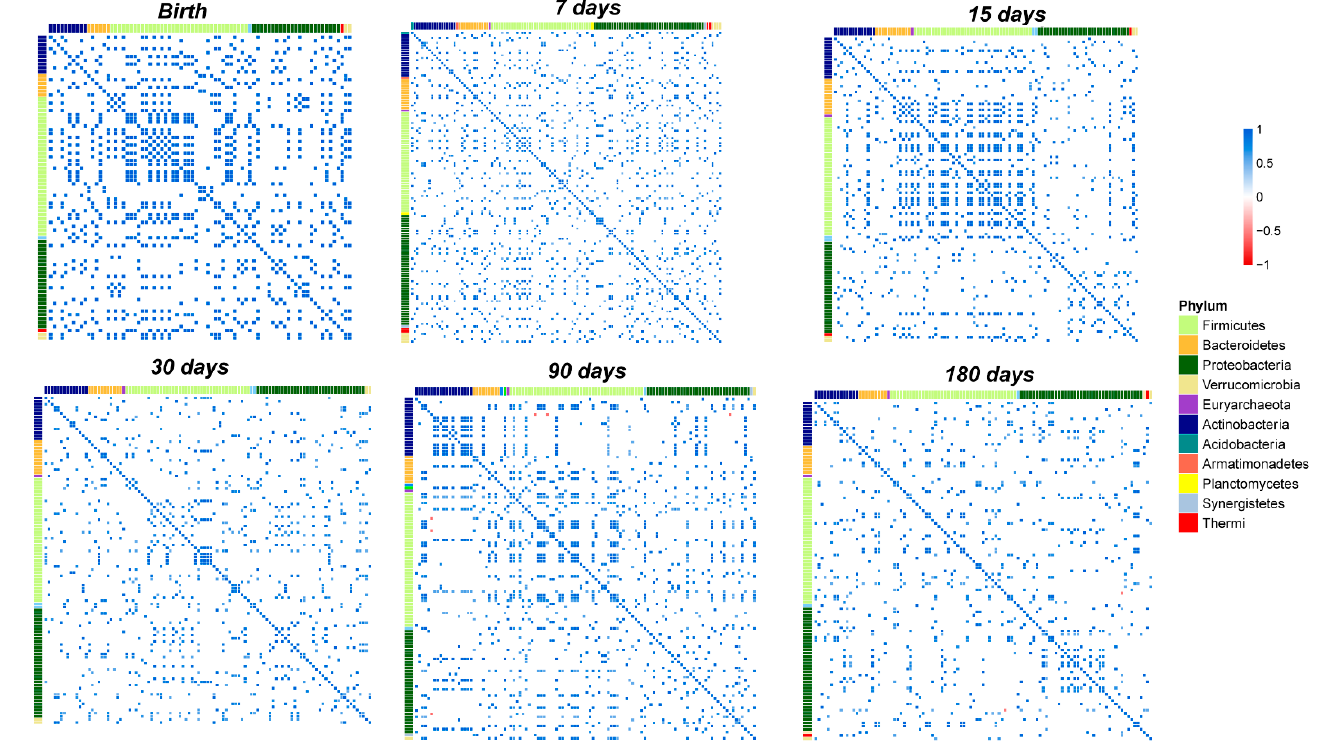
Figure 7. Pearson’s correlation heatmaps of fecal OTUs. Panels that are labelled as Birth, days 7, 15, 30, 90, and 180 show the correlation (coloured squares) heatmaps between the OTUs. Pearson’s correlations with p FDR < 0.05 are presented. The colour scale represents the correlation level of each variable: red, negative correlation values; blue, positive correlation values. The OTUs are coloured according to the phylum level